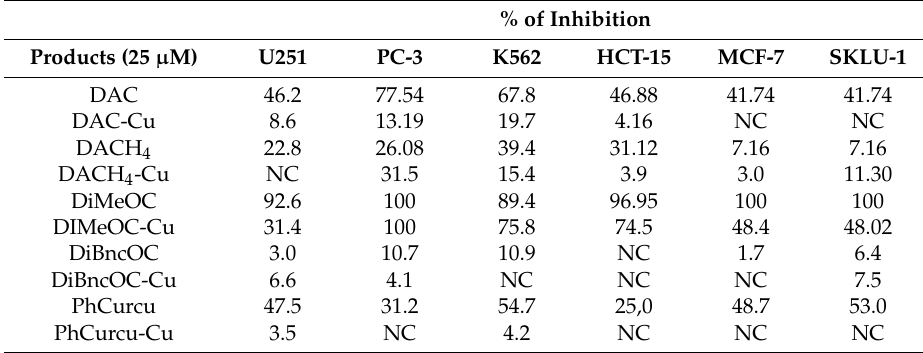
Table 6. Cytotoxic Screening of ligands and their copper complexes 1 – 10 . % of